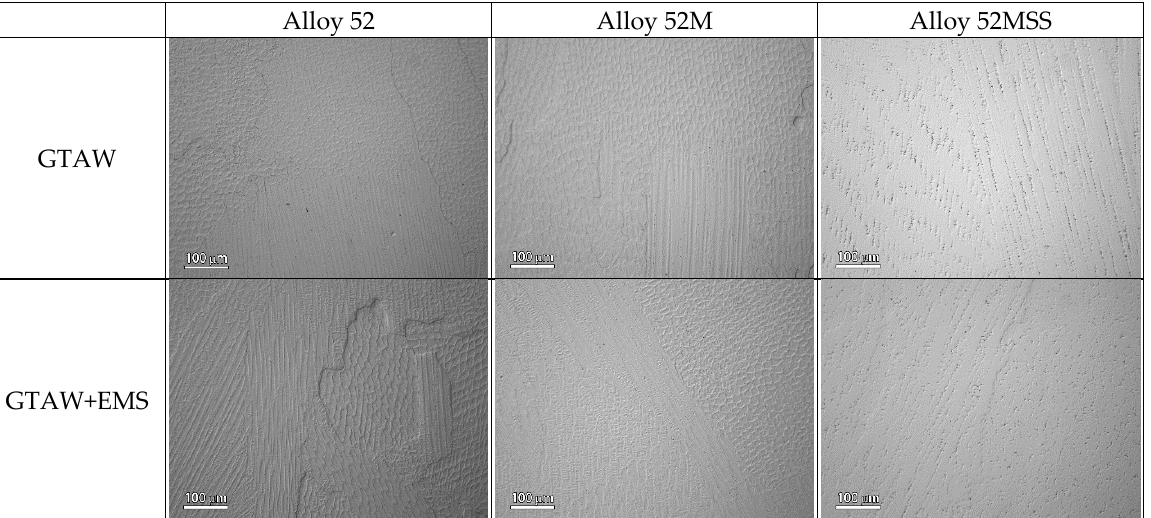
Figure 6. Micrographs of welds in the middle.